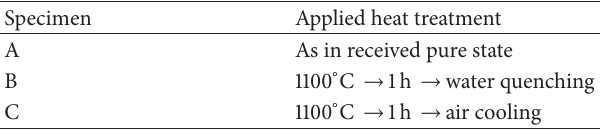
Table 1: Applied heat treatments and following quench cases.